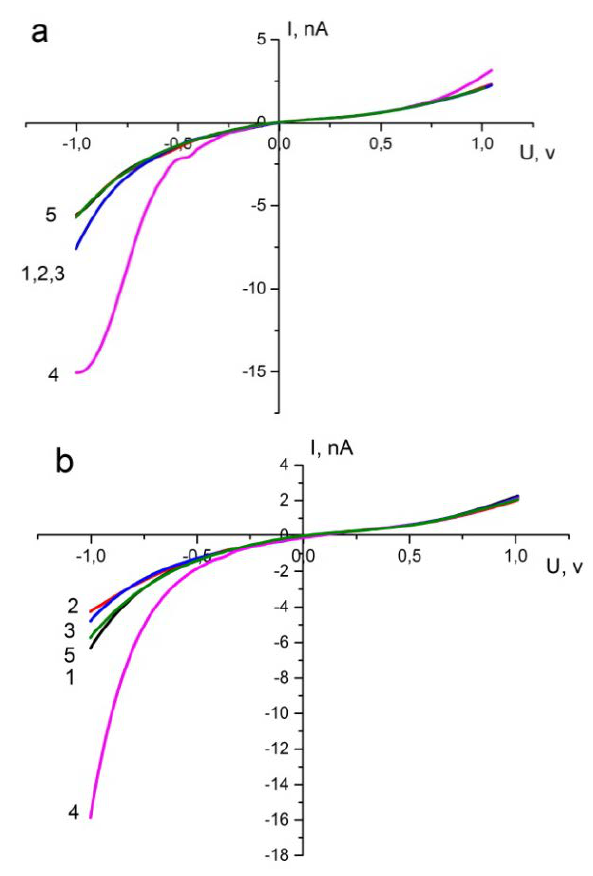
Figure 3. LTCVCs, measured at points along the edge of the step (a) and along the normal to the edge of the step